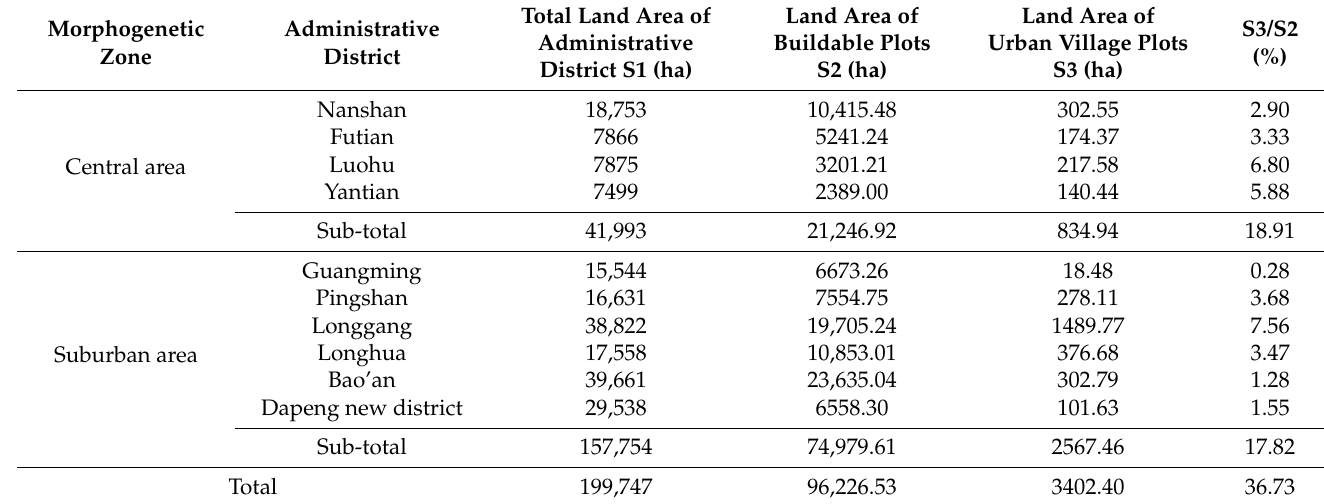
Table 2. Proportion of urban village redevelopment in each administrative